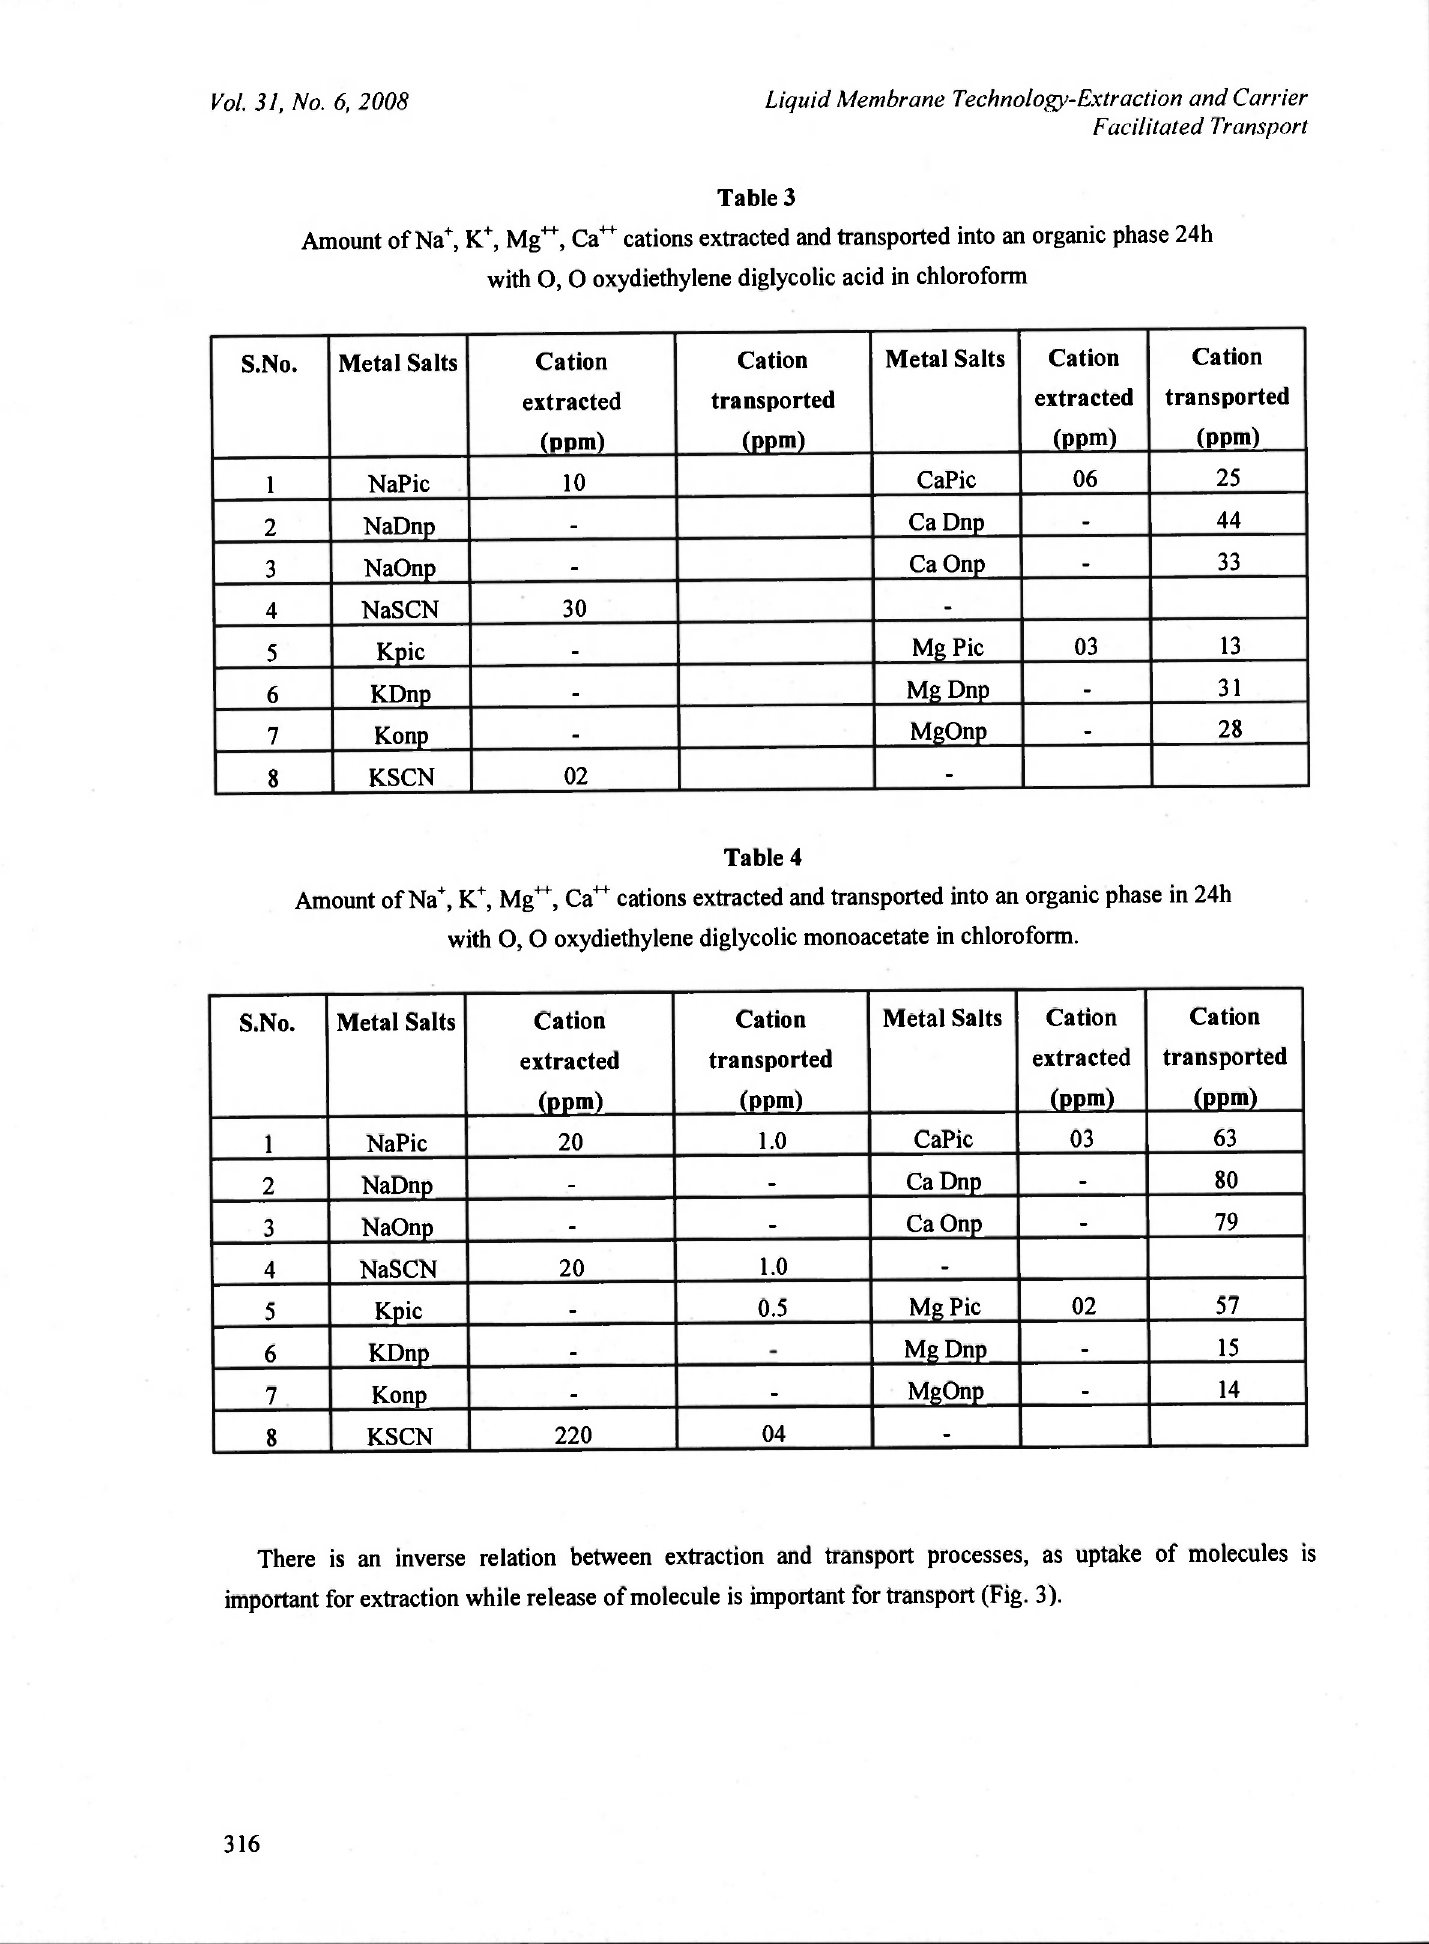
Amount of Na + , K + , Mg^, Ca^ cations extracted and transported into an organic phase 24h with Ο, Ο oxydiethylene diglycolic acid in chloroform